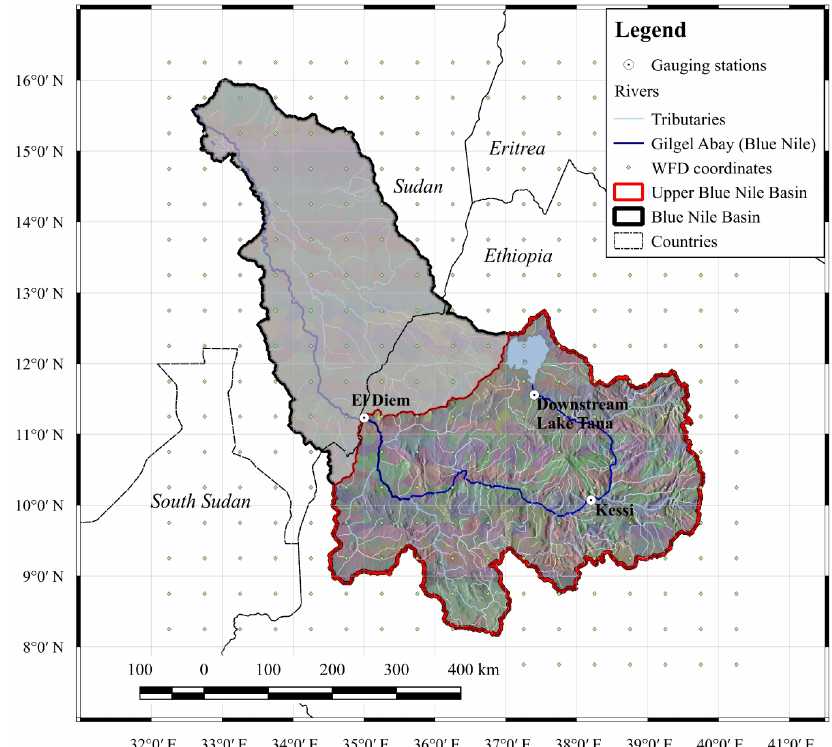
Figure 1. Map of the Blue Nile River basin. The Upper Blue Nile (UBN) catchment (172000km 2 ) is enclosed by the red line. The three gauges used for model calibration and validation are represented by white